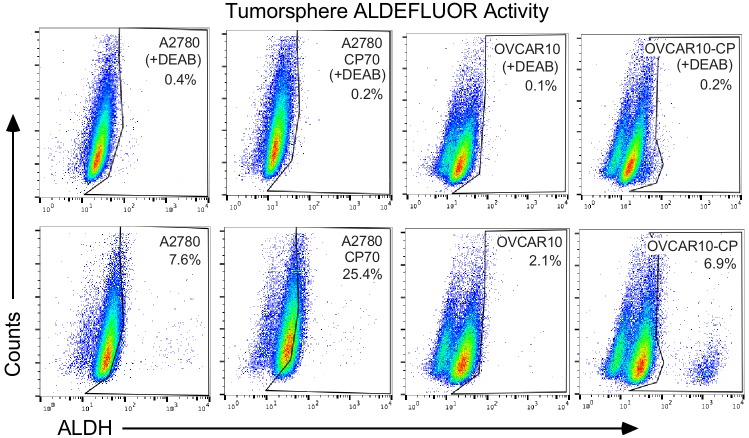
ALDEFLUOR assays.Representative flow cytometry profiles of A2780, A2780-CP70, OVCAR10, and OVCAR10-CP cells grown as tumorspheres with or without N,N-diethylaminobenzaldehyde (DEAB) and analyzed by ALDEFLUOR assay to identify populations of ALDH-bright (ALDH+) cells. Percent of total ALDH+ cells for each is indicated.